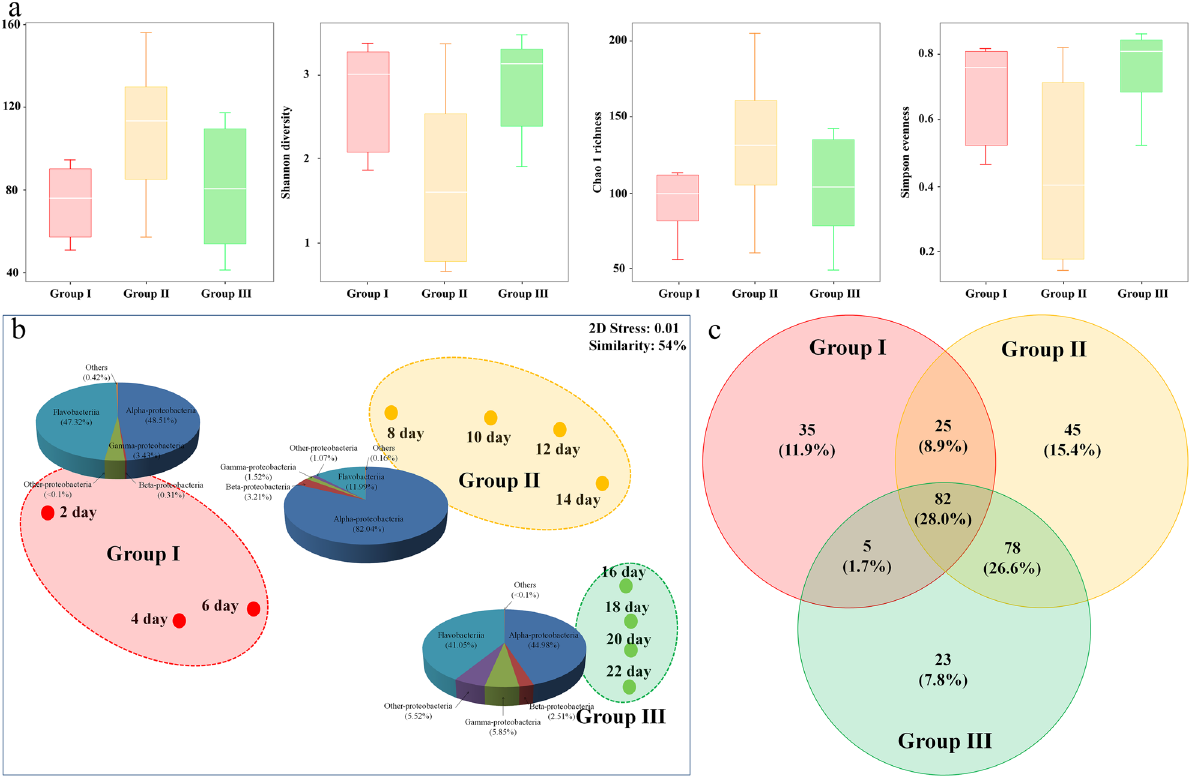
Figure 1. Alpha diversity and the distribution of operational taxonomic units (OTUs) in the bacterial community during Akashiwo sanguinea bloom (Group I) and late/decline stage (Group II) to post-bloom stage (Group III)” within an indoor microcosm. ( a ) Box plots of alpha diversity (median, min and max) showing the numbers of OTUs, Shannon diversity, Chao1 richness and Simpson evenness. ( b ) Non-metric multidimensional scaling plot using the Bray–Curtis similarity method. The pie charts indicate the high-ranking taxonomic distribution at the class level of the bacterial community. ( c ) Venn diagram showing the shared and unique bacterial operational taxonomic units. Figure 1c was generated with Veeny v2.1.0 (https:// bioin fogp. cnb. csic. es/ tools/